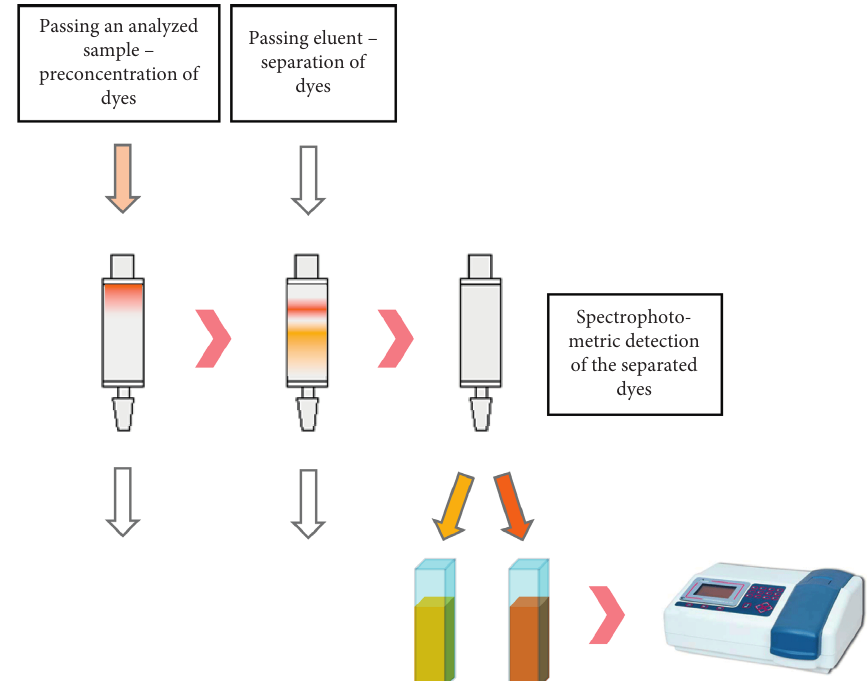
Figure 1: Scheme of the proposed method for sorption-spectroscopic determination of dyes with the preconcentration and separation on a single